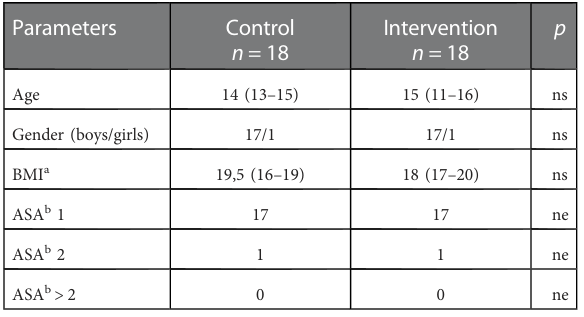
TABLE 1 Demographic data from patients in both groups.